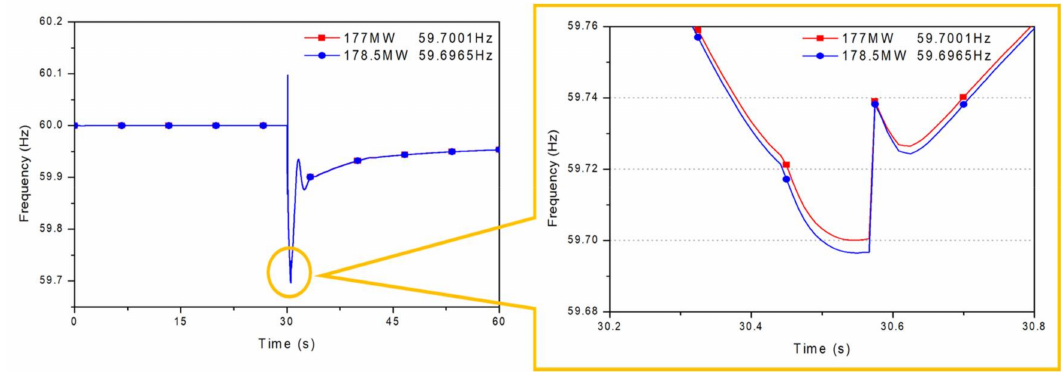
Figure 12. Frequency of Jeju power system at the merit order 4 when the wind farm is lost.